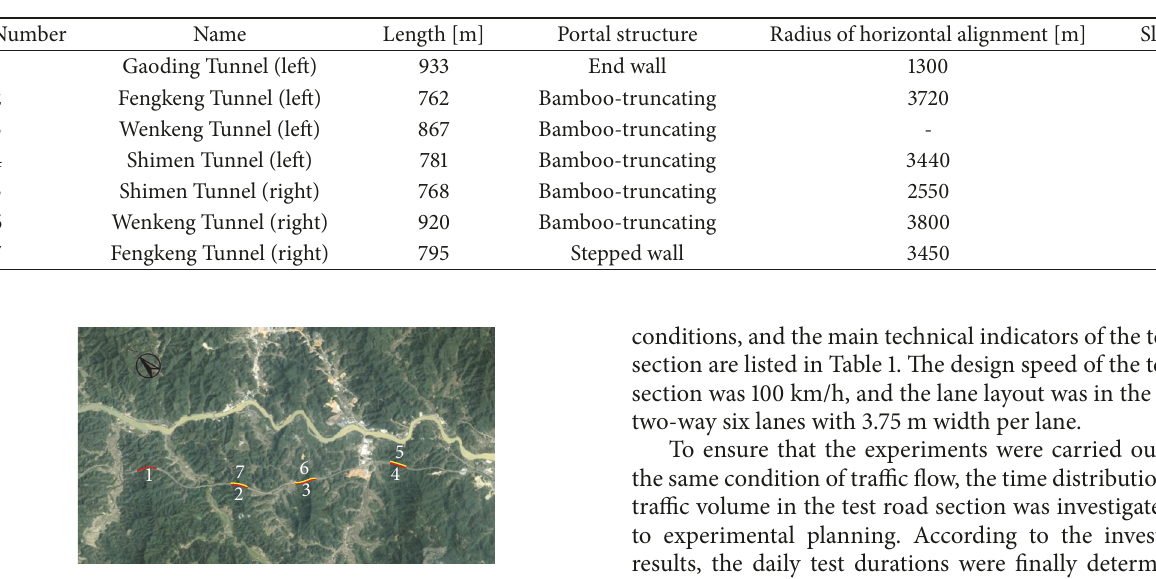
Table 1: Information of test tunnels.